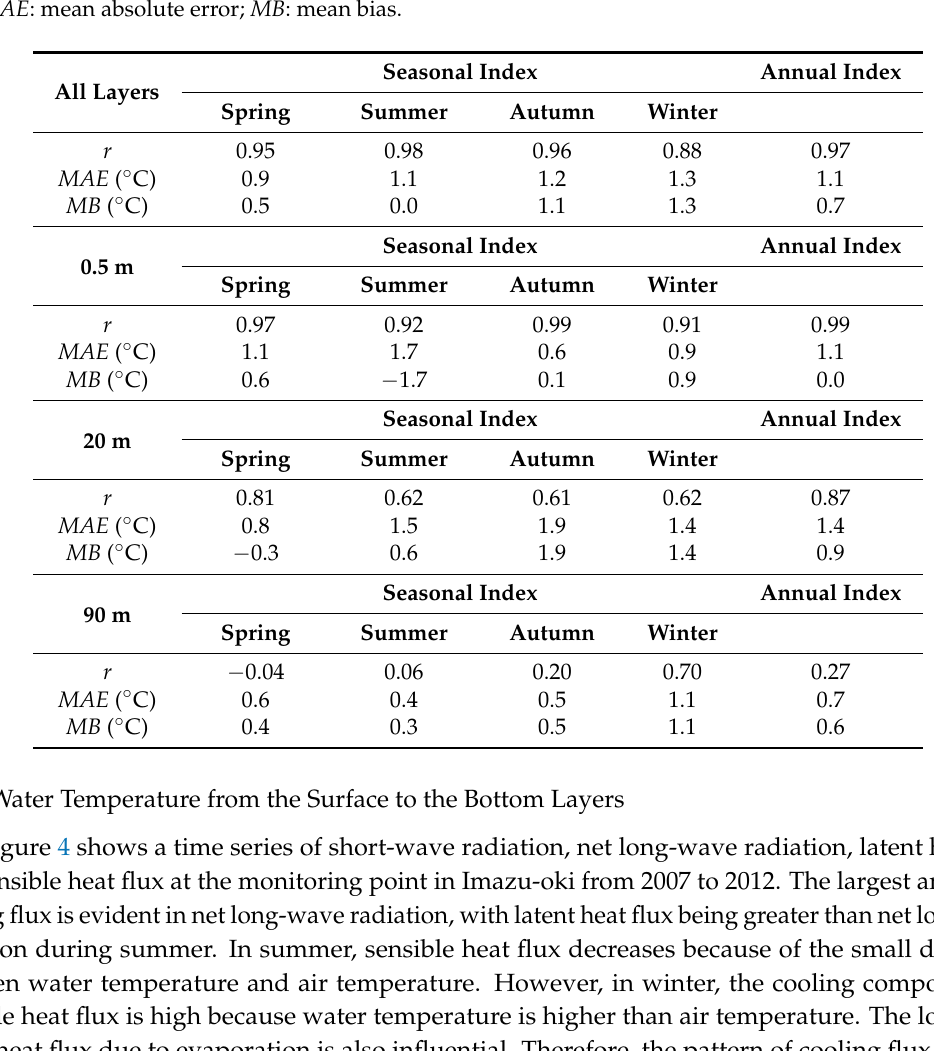
Figure 5. Time series of observed and simulated water temperature at depths of 0.5 m, 20 m, and 90 m at the monitoring point in Imazu-oki. 3.2. General Model Results 3.2.1. Seasonal Change of the Structure of Stratification at the Monitoring Point in Imazu-Oki The water distributions along the line passing from west to east through the monitoring point in Imazu-oki are shown in Figure 6. The snapshots were taken at 12:00 p.m. from April 2007 to February 2008 every two months. The vertical distributions of water temperature each year are not very different from each other; accordingly, we picked the values in 2007 as a representative year for the current analysis. As is evident in the observations, the water temperature of the surface rises from spring to summer, and the stratification becomes strong. However, the mixed layer is formed by the mixing of the wind in the surface layer. The difference between the surface layer and the bottom layer becomes large, and the thermocline is formed as a result. The thickness of the thermocline increases as the air temperature rises. In a stratified season, the water temperature on the eastern coast rises slightly higher than that of the central and western coasts. As the water depth on the eastern coast is shallower than the ones on the central and western coasts, the water parcel on the eastern coast is heated more easily than in other places. Therefore, the stratification tilts slightly. In the cooling season, the surface of the lake cools down as the air temperature decreases. Due to the cooling flux and the effect of the wind, the thermocline deepens. In addition, since the water depth on the eastern coast is shallower than the one on the central and western coasts, the water parcel on the eastern coast is cooled more easily than in other places, as shown in Figure 6d–f. The stratification again tilts slightly due to the nonuniformity in the topography of the bottom. In December, there is still little difference in the water temperature